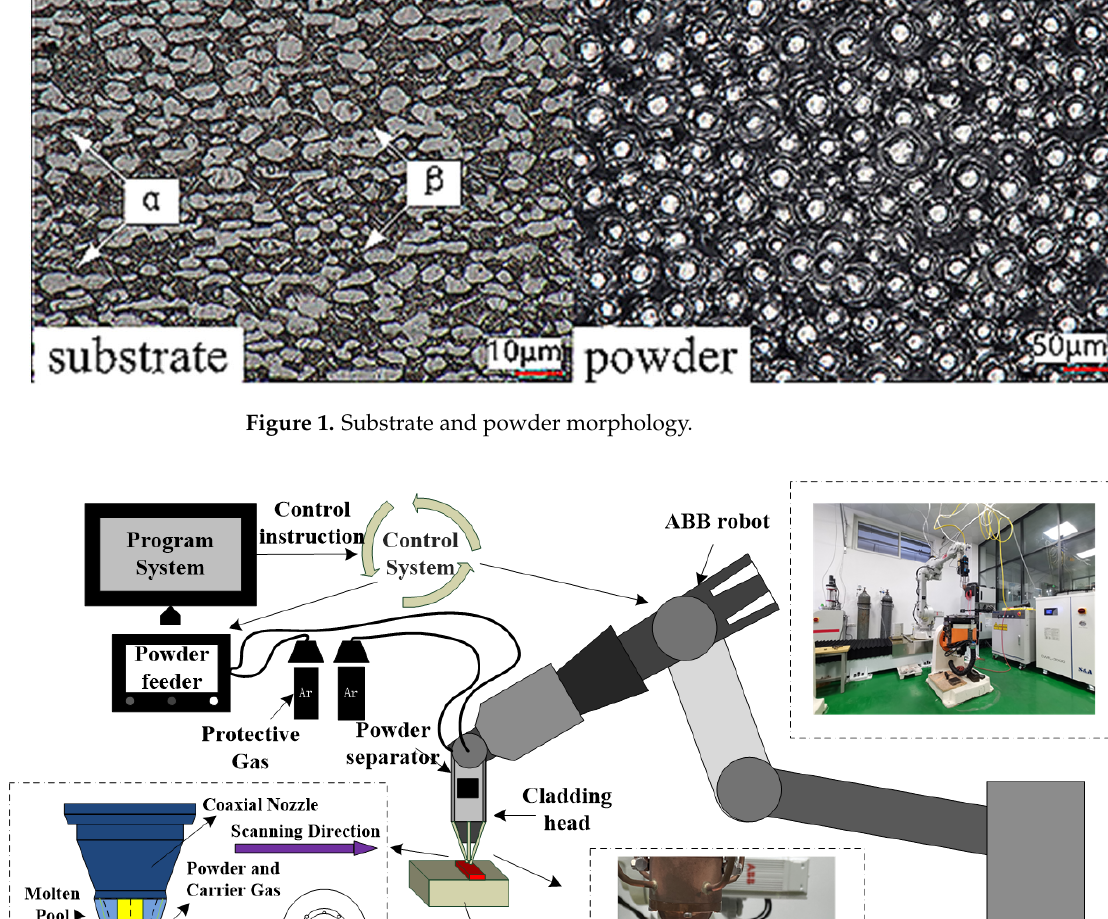
Figure 1. Substrate and powder morphology.